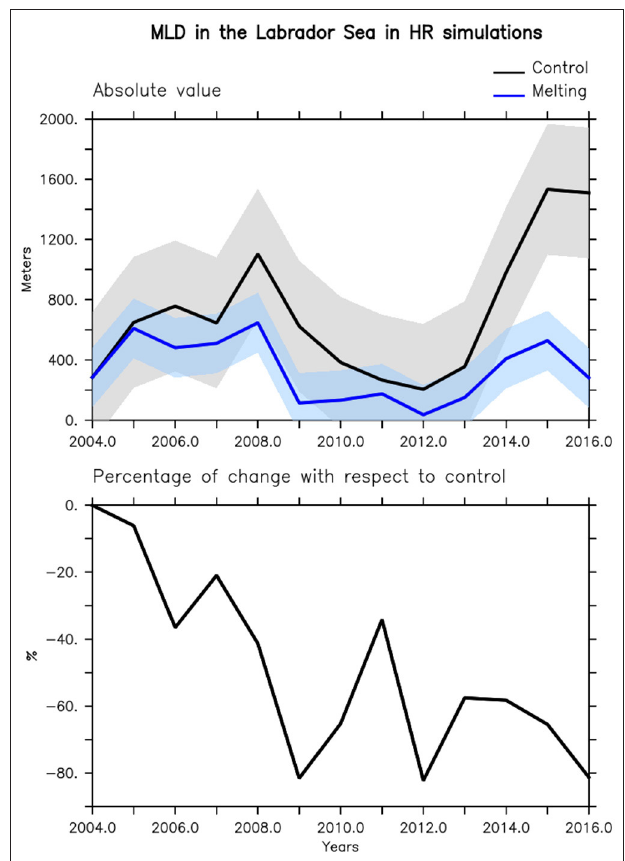
FIGURE 5 | Winter mixed layer depth in the Labrador Sea as defined by the red contour in Figure 1 , in the HR simulations, in black for the control and in blue for the melting simulations. The interannual standard deviations over the whole period is represented by the colored overlap of each curve. The annual mean values (in meters) are shown in top, while the changes in melting simulation with respect to control ones are shown in the bottom panel (in